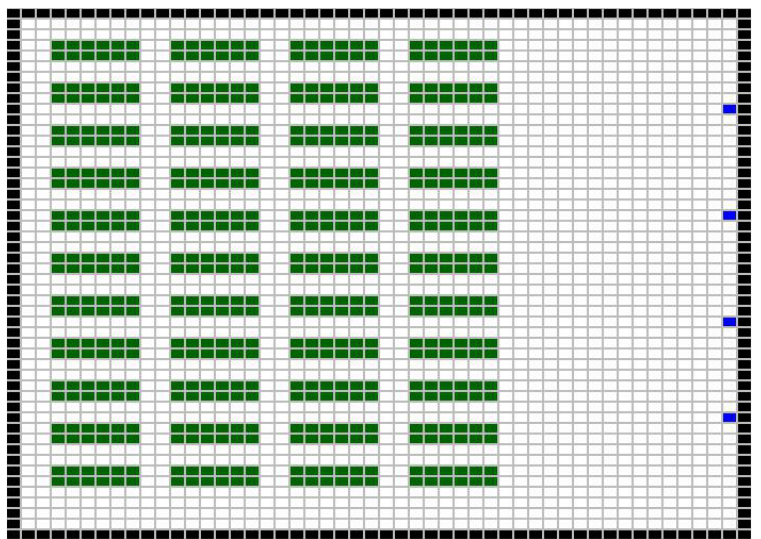
Figure 1. Warehouse layout. Green blocks mean shelves on which items are contained in a warehouse. The blue blocks mean depots in which the robot starts driving and returns. The white blocks are free areas where the robot can move. The black blocks mean stuck areas where the robot cannot